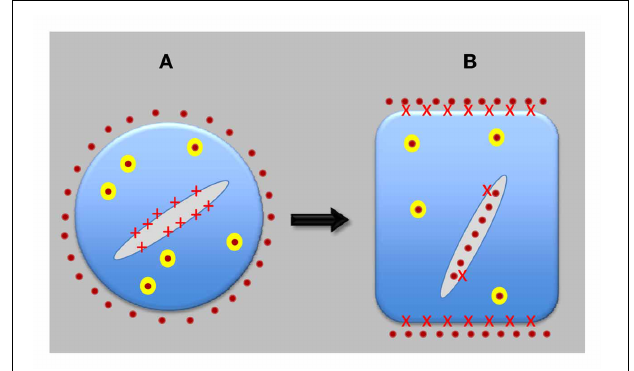
FIGURE 2 | Evolution of neuron-like plant cells. Auxin-transporting synapses evolved only after plant cells transferred most of PINs from the endoplasmic reticulum (ER) to the plasma membrane (PM) and, in the opposite direction, most of ABP1 from extracellular space to the ER lumen. ABP1 then got access to cell periphery only in a strictly controlled manner and started to act as a central organizer of auxin-transporting synapses. Both PINs and ABP1 are integrated with sensory systems and also control motor responses of root apices. (A) Shows pre-synaptic cell, and (B) shows synaptic cell, as found in the root apices of contemporary higher plants. Red crosses depict APB1; yellow balls are recycling vesicle; and orange dots represent